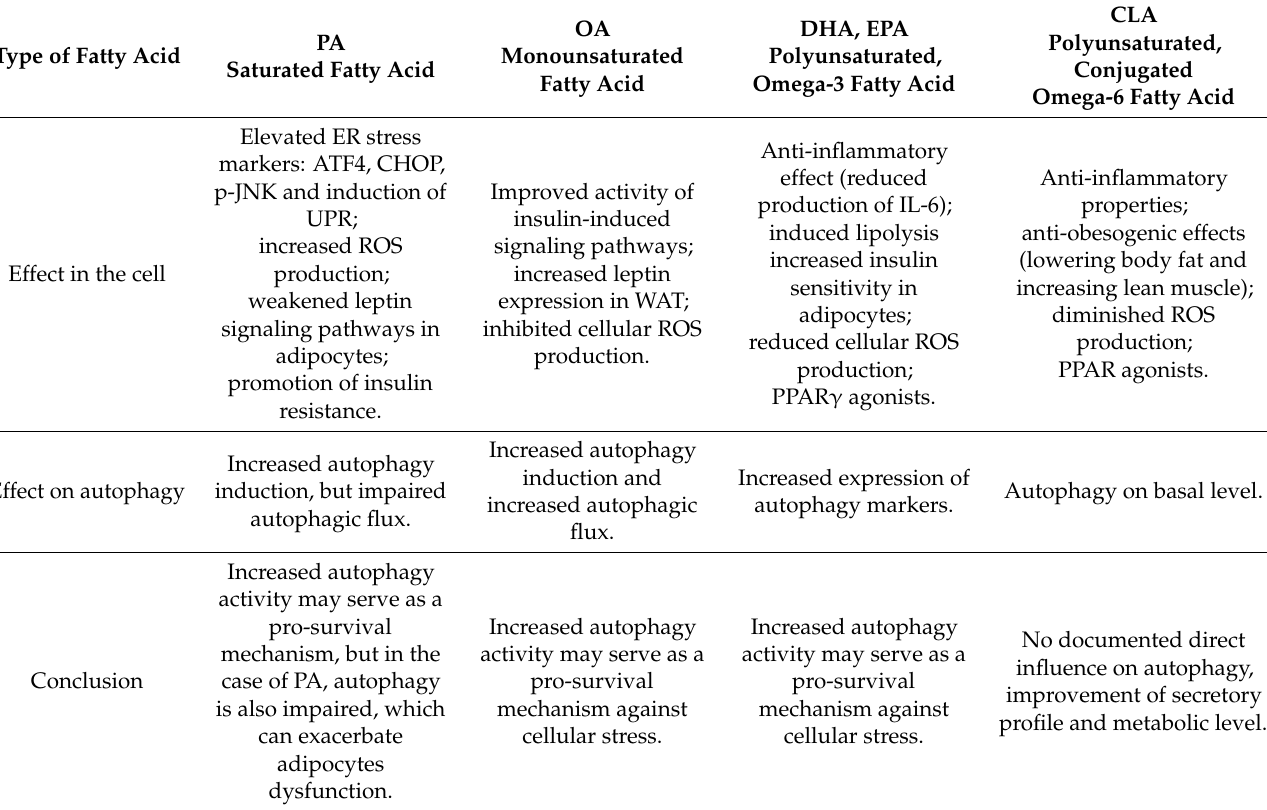
Table 1. Summarized effects of fatty acids on autophagy in